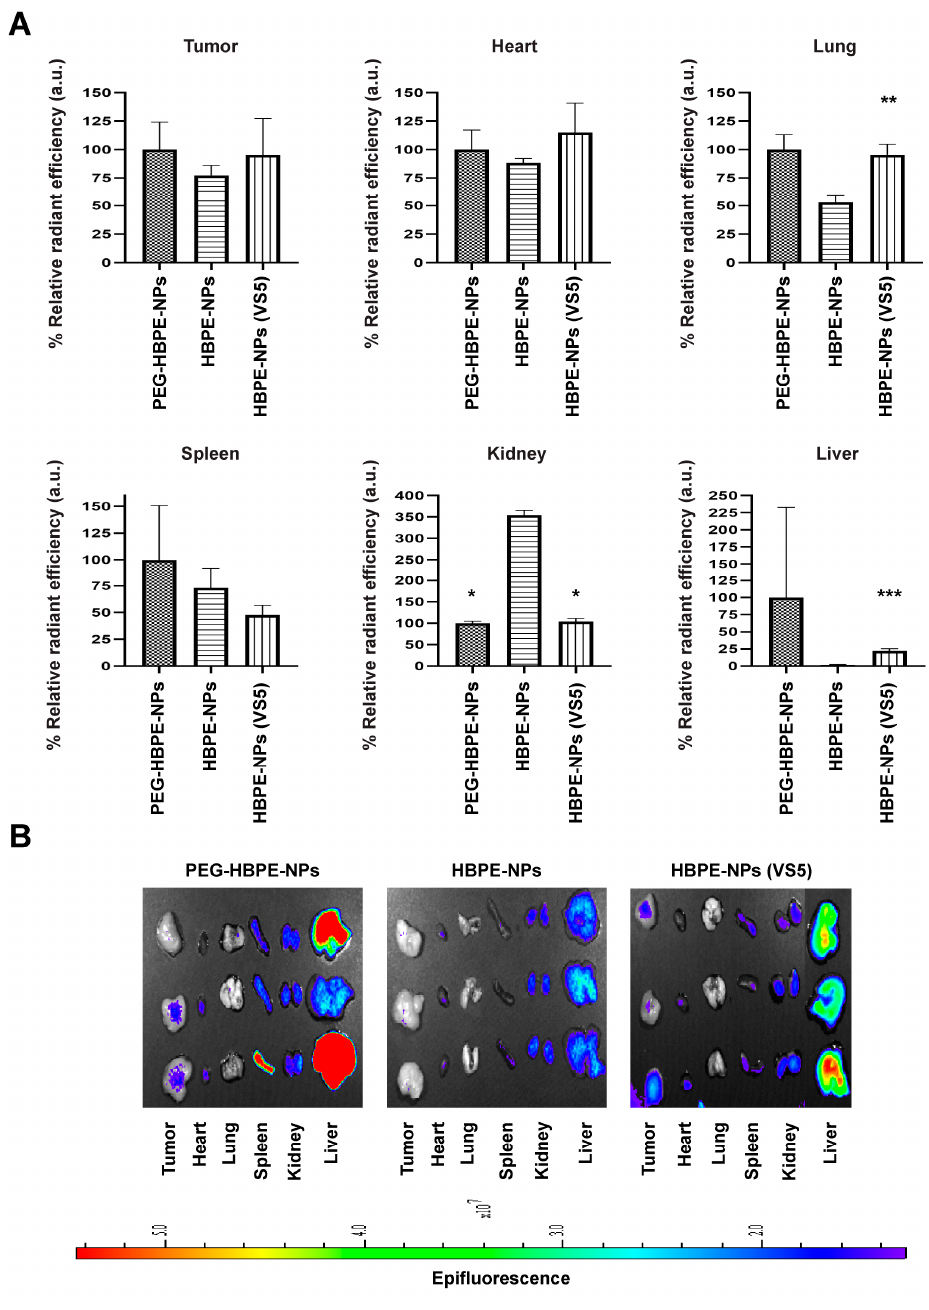
Figure 5. Biodistribution of HBPE-NPs in mice is modulated by pre-treatment with VS5. Nu/Nu nude mice were orthotopically injected with 8 × 10 5 MDA-MB-231 cells in the mammary fat pad. Upon tumors reaching 1000 mm 3 , mice were intravenously injected with DiR dye-encapsulated PEG-HBPE-NPs, HBPE-NPs, and HBPE-NPs (VS5) and imaged 7 h post-treatment. Images were acquired with an IVIS Lumina S5 and quantified with Living Image software. Fluorescence concentrated in each organ (nanoparticle presence) was quantified relative to PEG-HBPE-NPs; ( A ) bar graphs (upper panels) and ( B ) organ images (lower panels). Images represent nanoparticle uptake (DiR fluorescence) in the tumor, heart, lungs, spleen, kidneys, and liver. Blue color constitutes low nanoparticle accumulation and red/yellow color constitutes high nanoparticle accumulation. Data represent mean ± standard deviation ( n = 3). * p -value < 0.05, ** p -value = 0.0034 and *** p -value = 0.0199 relative to HBPE-NPs. To identify specific proteins absorbed by HBPE-NPs from VS3 and VS5, we used a mass spectrometry approach to analyze the proteome from VS3-treated and